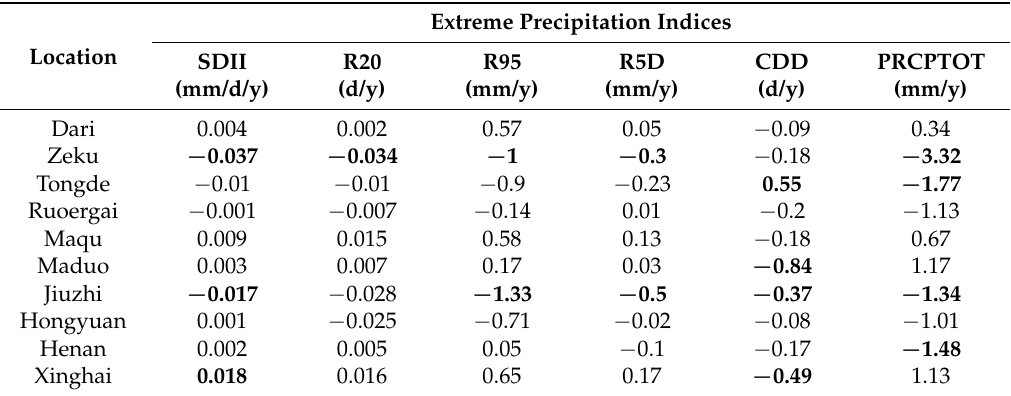
Table 3. Linear trends for the extreme precipitation at selected locations 1 .